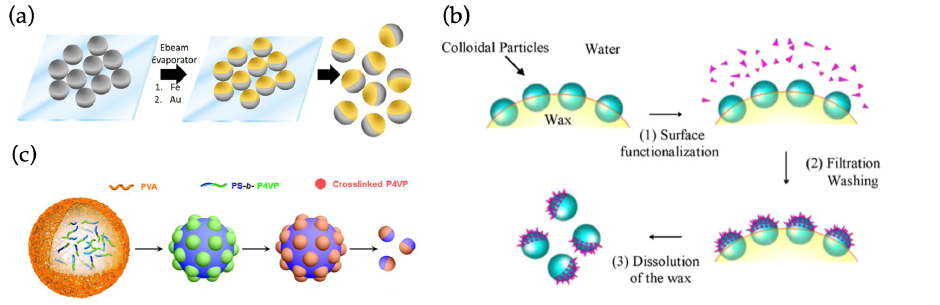
Figure 2. The three main mechanisms of Janus particle fabrication, illustrated with selected examples. ( a ) Masking: electron beam evaporation or sputtering can be used to deposit material on surface- attached spheres. ( b ) Phase separation: phase boundaries (here, water–wax interface) can be used to direct assembly. ( c ) Self-assembly: For example, copolymers can be selectively cross-linked and then disassembled to yield Janus spheres. ( a ) reproduced from Ref. [45]. Copyright 2017 American Chemical Society. ( b ) reproduced from Ref. [46]. Copyright 2009 Elsevier. ( c ) reproduced